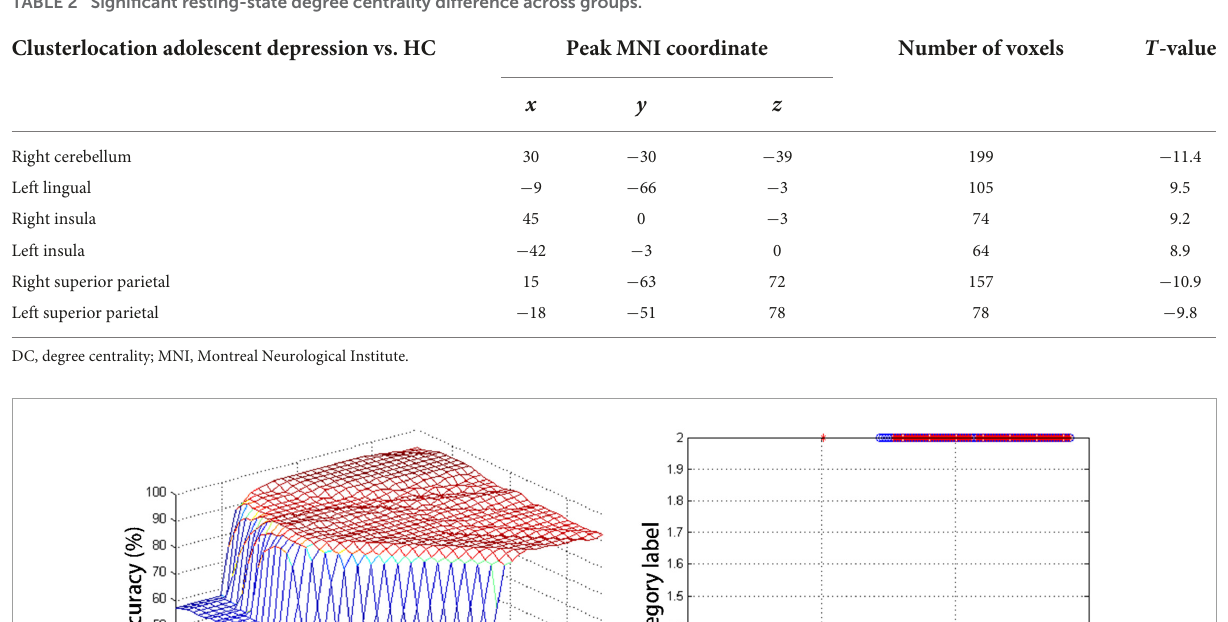
TABLE 2 Significant resting-state degree centrality difference across groups.